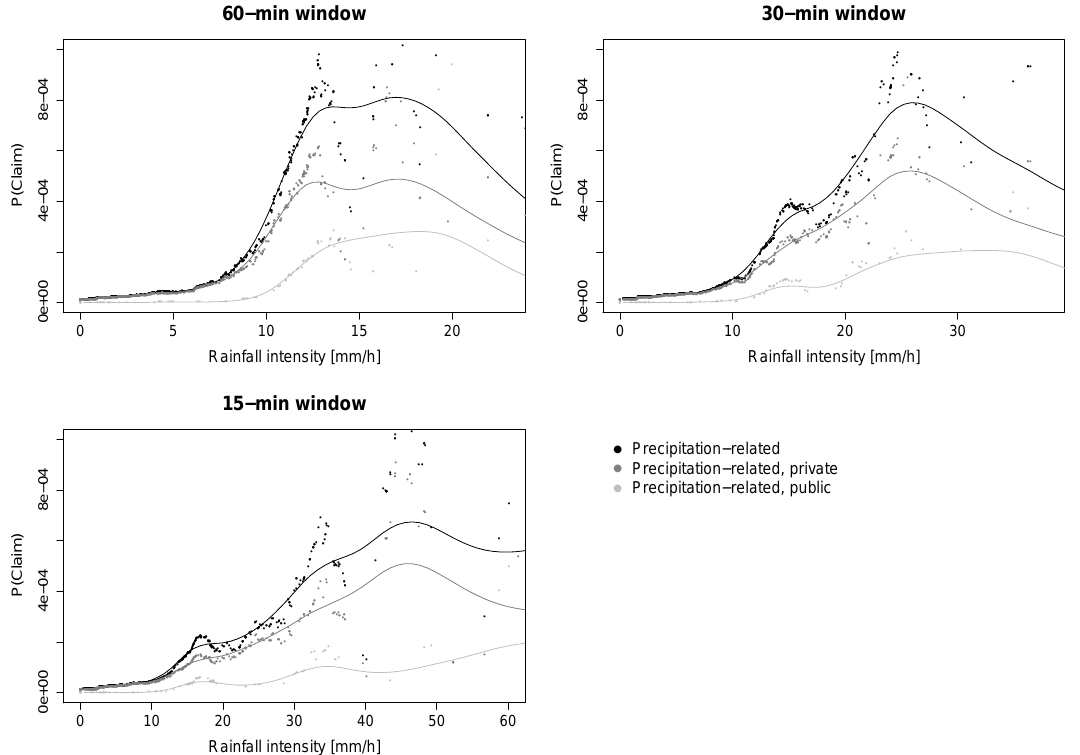
Figure 5. The empirical probability of precipitation-related claim occurrence per day per risk address as a function of rainfall intensity, using a 60-min (top left panel), 30-min (top right panel) and 15-min moving time window (bottom left panel). Results are related to precipitation- related claims (black dots), broken down to those classified as “private” (grey dots) and “public” (light grey dots). The range of x values is from 0mmh − 1 to the rainfall intensity associated with a return period of 5years. Locally-weighted regression lines are based on penalised